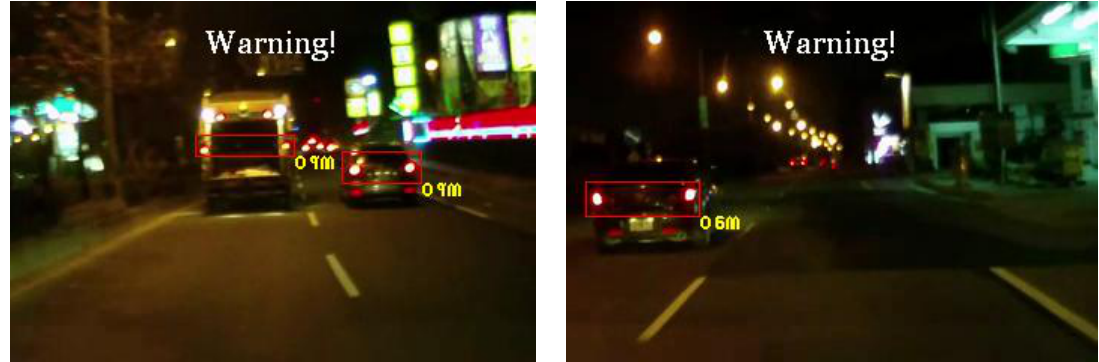
Figure 17. Results of vehicle detection and event determination for a nighttime rural road under a normal illumination with free-flowing traffic conditions (Test video 1).